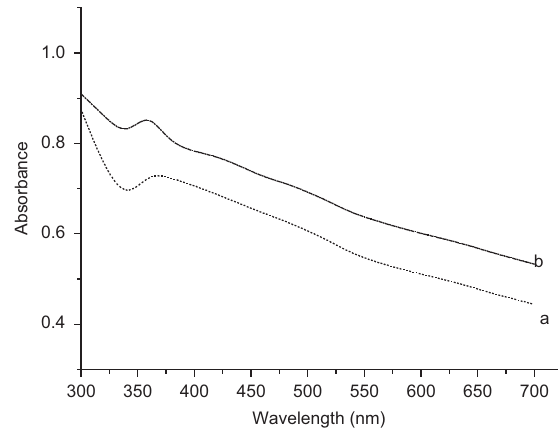
Figure 7 XRD patterns of MMT, Ag-MMT-N, and Ag-MMT for the determination of d-spacing.